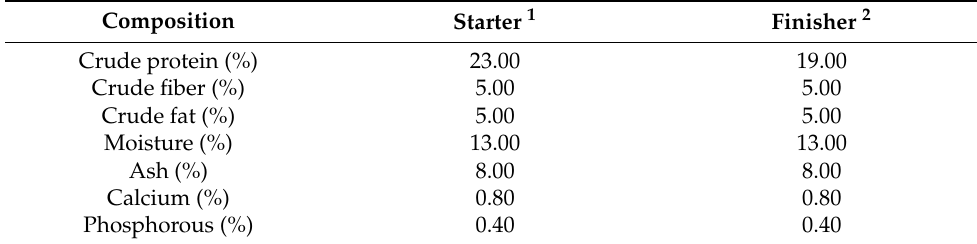
Table 1. Nutrient compositions of commercial broiler starter and finisher